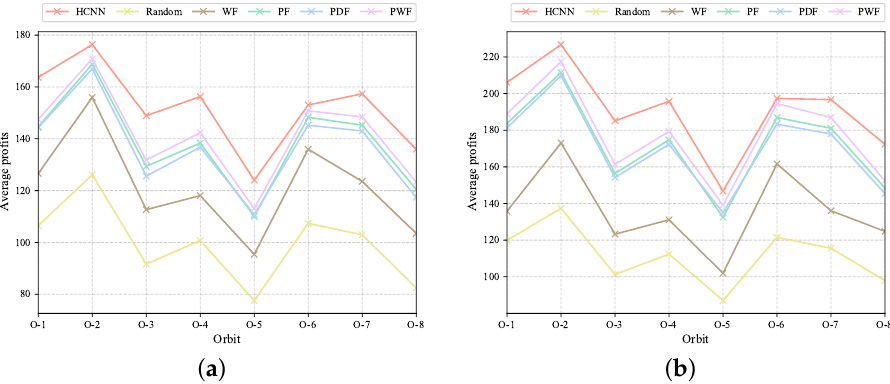
Figure 10. Performance of HCNN at different sizes. ( a ) Average profits for the single-orbit scenarios with 50 tasks; ( b ) Average profits for the single-orbit scenarios with 100